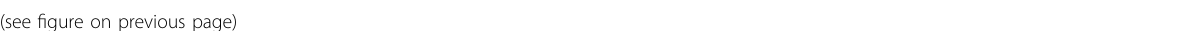
Fig. 4 Neurog2 converts astrocytes into neurons from intact mouse dorsal spinal cord in vivo. a , b Double staining of mCherry and GFAP on transections of the dorsal spinal cord from WT mice infected with AAV-mCherry ( a ) or AAV-Neurog2/mCherry ( b ) at 3 DPI. Upper left, upper right, bottom left, and bottom right represent mCherry, GFAP, DAPI, and merged images, respectively. Arrows in merged images indicate mCherry + GFAP + cells. Scale bar: 20 μ m ( a , b ). c – d ″″ Double staining of mCherry and NeuN on transections of the dorsal spinal cord from WT mice that were infected with the control virus AAV – mCherry ( c – c ″″ ) or AAV-Neurog2/mCherry ( d – d ″″ ) on day 3. e – f ″″ Double staining of mCherry and NeuN on sections of the dorsal spinal cord from WT mice that were infected with the control virus AAV – mCherry ( e – e ″″ ) or AAV-Neurog2/mCherry ( f-f ″″ ) on day 30. Panels ( c ″″ , d ″″ , e ″″ , f ″″ ) are higher magni fi cations of the boxed areas in ( c ″ ′ , d ″ ′ , e ″ ′ , f ″ ′ ), respectively. mCherry was not colocalized with NeuN (arrowheads), mCherry colocalized with NeuN (arrows). Arrows and arrowheads in ( c ″″ , d ″″ , e ″″ , f ″″ ) represent mCherry + NeuN + cells and mCherry + NeuN - cells, respectively. Scale bars: 50 μ m ( c ″ ′ , d ″ ′ , e ″ ′ , f ″ ′ ) and 25 μ m ( c ″″ , d ″″ , e ″″ , f ″″ ). g The statistical data of astrocyte-to-neuron conversion ef fi ciency induced by Neurog2 at different time points. A one-way ANOVA revealed a signi fi cant effect of group, followed by Tukey ’ s multiple comparison test. ***Represents p < 0.001; h – h ″″ 3D images of ( f ″″″ ) : ( h ) front view of ( f ″″ ), ( h ′ ) left side of view of ( h ) rotated 30°, ( h ″ ) top view of ( h ) rotated 30°, ( h ″ ′ ) bottom view of ( h ), ( h ″″ ) right view of ( h ). The red arrows in ( f ″″ , h, h ′ , h ″ , h ″ ′ , h ″″ ) show a typical view of the same cell. i, j Immunostaining of Pax2 ( i ) and Tlx3 ( j ) on sections of spinal cord at 30